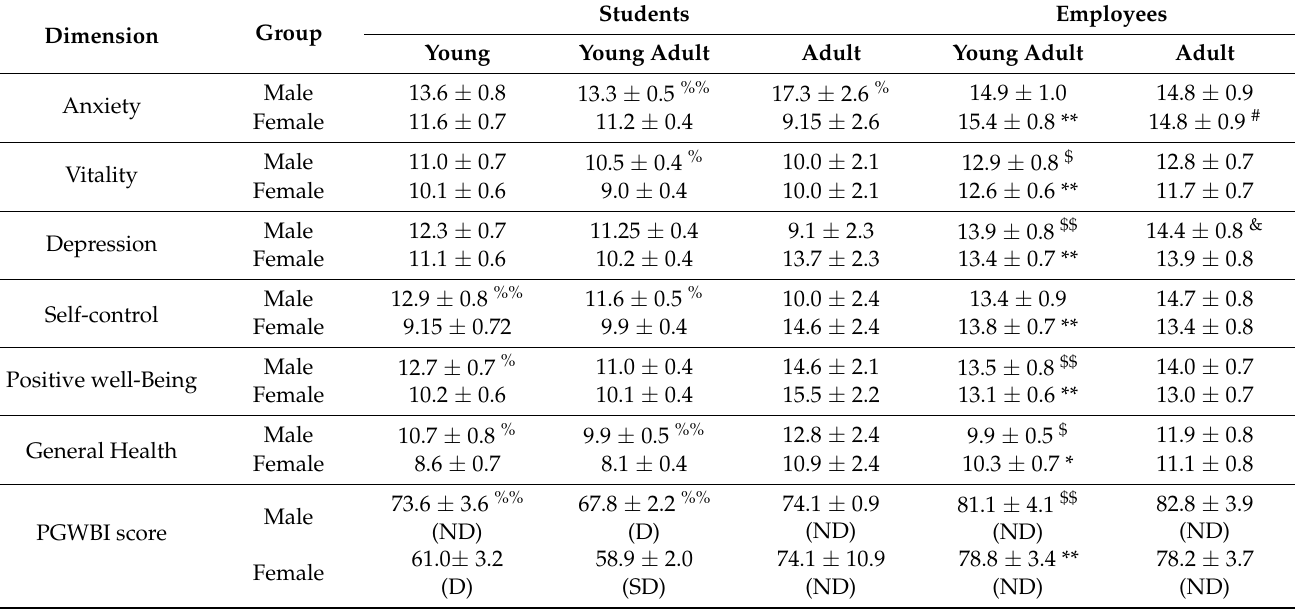
Table 2. Mean of PGWBI score and dimensions for male and female according to age